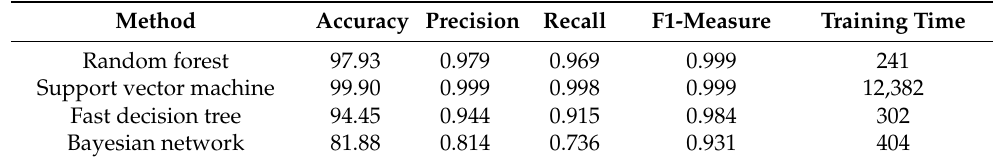
Table 5. Experimental results using the combined GoogleNet and ResNet18 features with differ- ent classifiers.